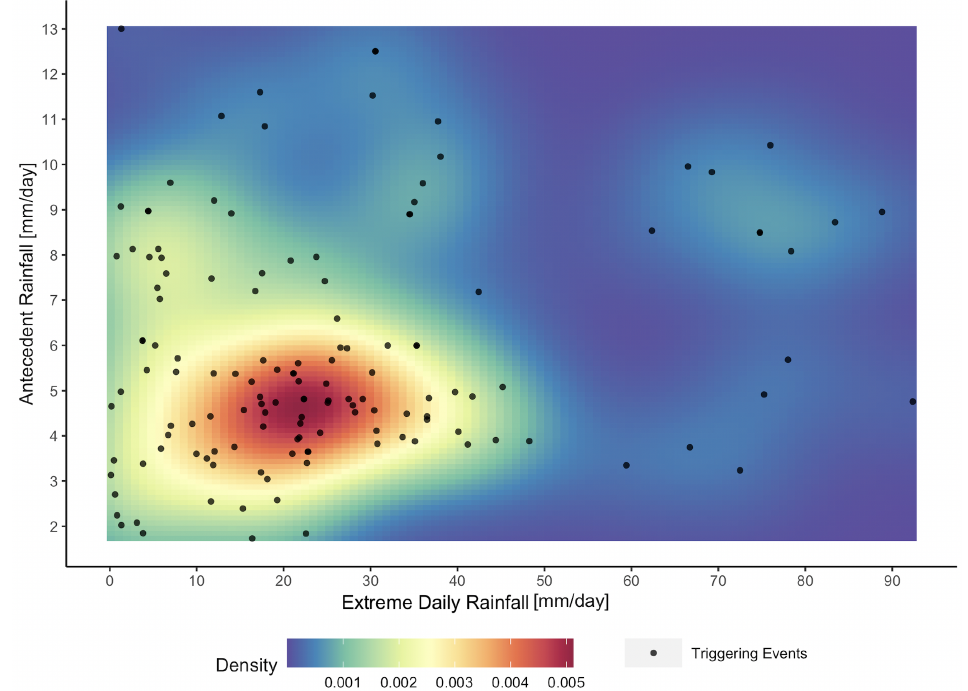
Figure 4. 2D density plot of the reconstruction of the extreme daily rainfall and the 30-day antecedent rainfall conditions from June to August of 1995–2005.